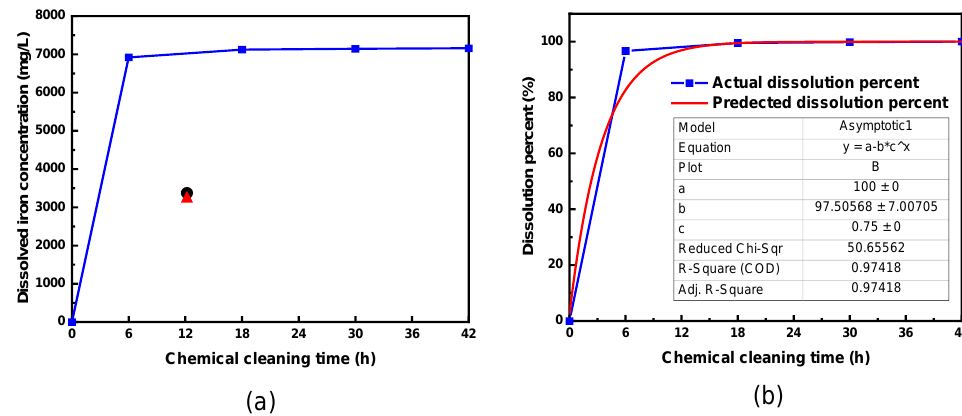
Figure 9. ( a ) Change in the iron concentrations dissolved from the full-length PCHE with cleaning time under the circulation condition. The solid black circle and red triangle denote the iron concentration dissolved in the first and second step, respectively. ( b ) Derivation of the empirical equation of dissolution percent using the dissolved iron concentration change curve with time.